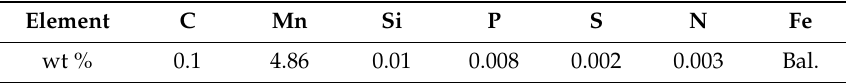
Table 1. Chemical composition of medium Mn